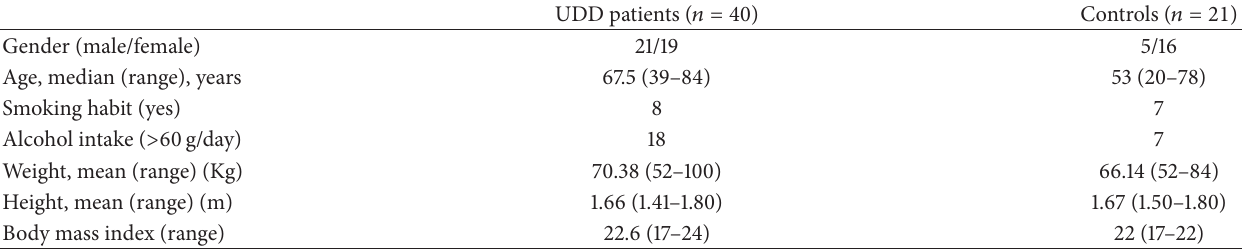
Table 1: Demographic and clinical characteristics of UDD patients and